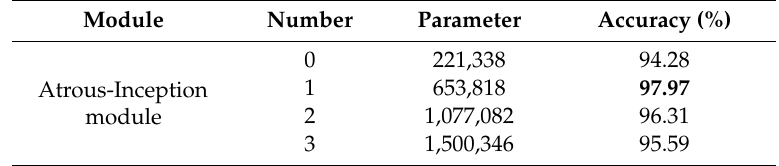
Table 4. E ff ect of the number of Atrous-Inception